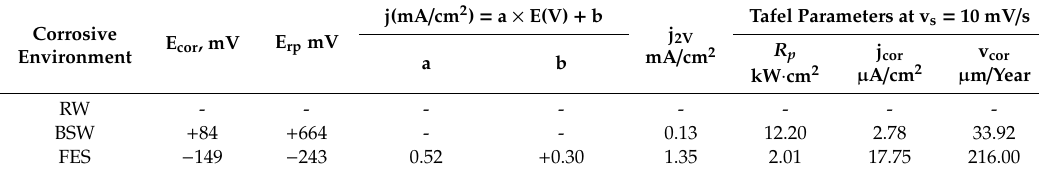
Table 16. Comparison between corrosion rates and current densities between PPS and other samples.